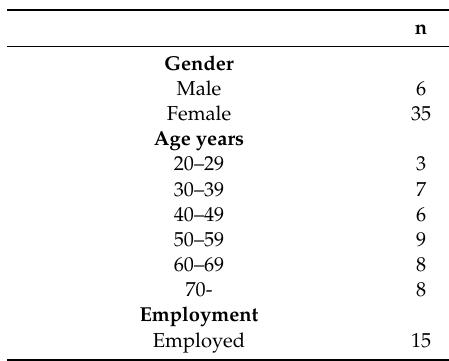
Table 1. Characteristics of study